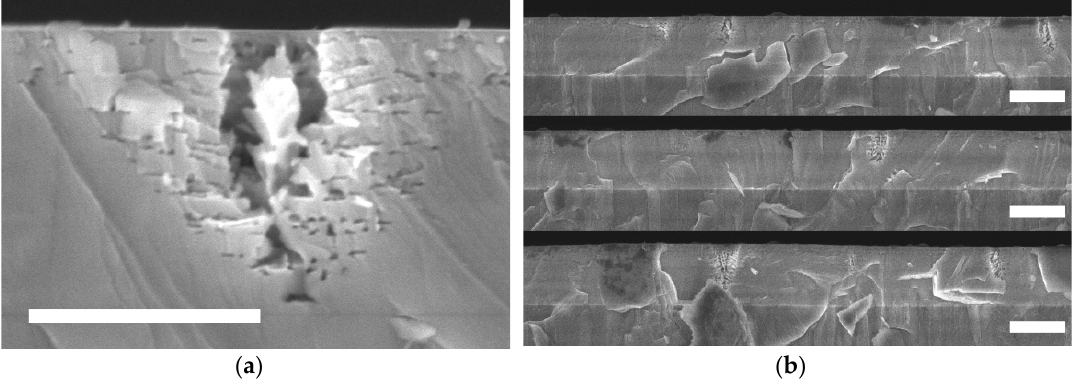
Figure 4. SEM micrographs of sample A, the AlGaN DBR on an AlN template, following a short etch. ( a ) shows a porous column with a scale bar of 500 nm. ( b ) shows 30 µm of continuous material in three images, showing the distribution of the columns. Scale bars are 1 µm.